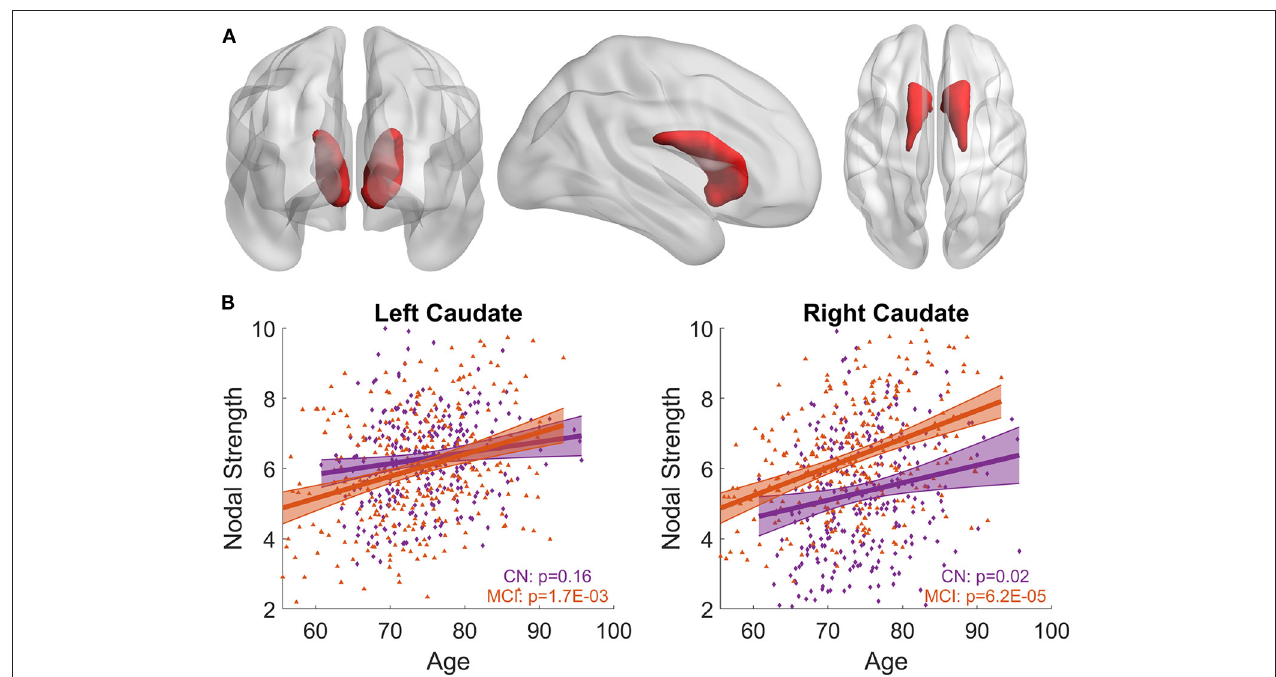
FIGURE 1 | Associations between bilateral caudate nodal strength and age. (A) Priori-defined bilateral caudate used in the analysis. (B) Scatter plot of the nodal strength from left/right caudate with age for MCI and CN separately. Shaded area represents 95% confidence interval of the fitting curve. The nodal strength shown in the figure has been adjusted to remove the influence of confounding factors using LME model; see Methods section for detail. Stronger age-related increase of caudate nodal strength is observed in MCI compared to